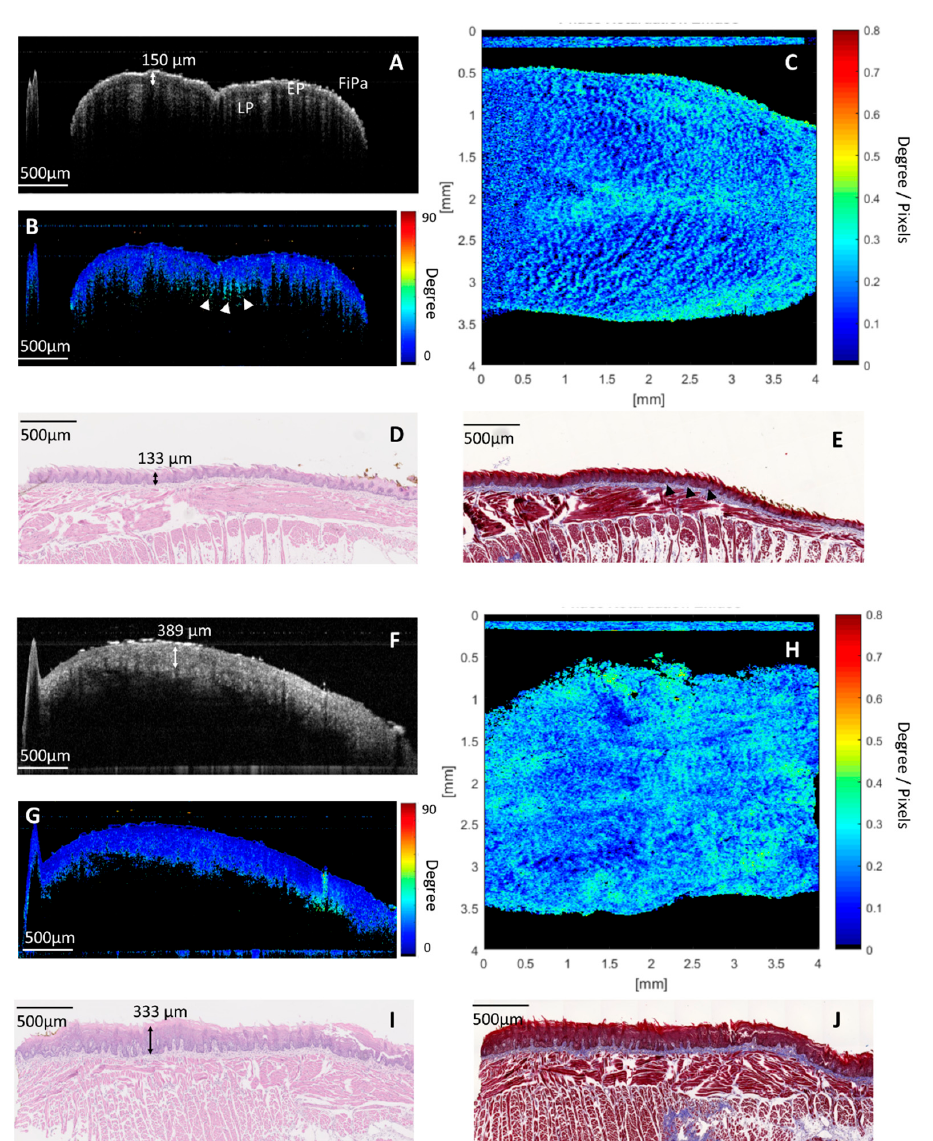
Figure 2. Images of the normal dorsal surface of the anterior tongue: ( A ) cross-sectional intensity optical coherence tomography (OCT) image. The microstructure of mucosa is shown, including filiform papilla (FiPa), the epithelium (EP), and the lamina propria (LP). ( B ) Cross-sectional cumulative PS-OCT image. The EP had low retardation. Some high retardant projection was seen beneath the EP (white arrowheads), where it is compatible with the collagen-abundant core of the papilla between the boundary of the EP and LP with Masson’s trichrome staining (black arrowheads in Figure 2E). ( C ) En-face birefringence map. Regularly arranged bright spots, where there are more birefringent agents like in the core of the papilla area, stand out against the homogeneous dark blue background. ( D , E ) Corresponding histology with hematoxylin and eosin (H&E) staining and Masson’s trichrome staining. Images of the dorsal surface of the anterior tongue with hyperplastic change: ( F ) cross-sectional intensity OCT image. An increased thickness of the EP was noted. ( G ) Cross-sectional cumulative PS-OCT. The thick EP showed low retardation. ( H ) En-face birefringence map. Blurred and irregular distribution of bright spots against a dark blue background. ( I ) Corresponding histology with H&E staining. Hyperkeratosis and increased thickness of the EP was noted. ( J ) Corresponding histology with Masson’s trichrome staining. The proliferation and irregular distribution of the collagen-abundant core of the papilla beneath the EP was seen.